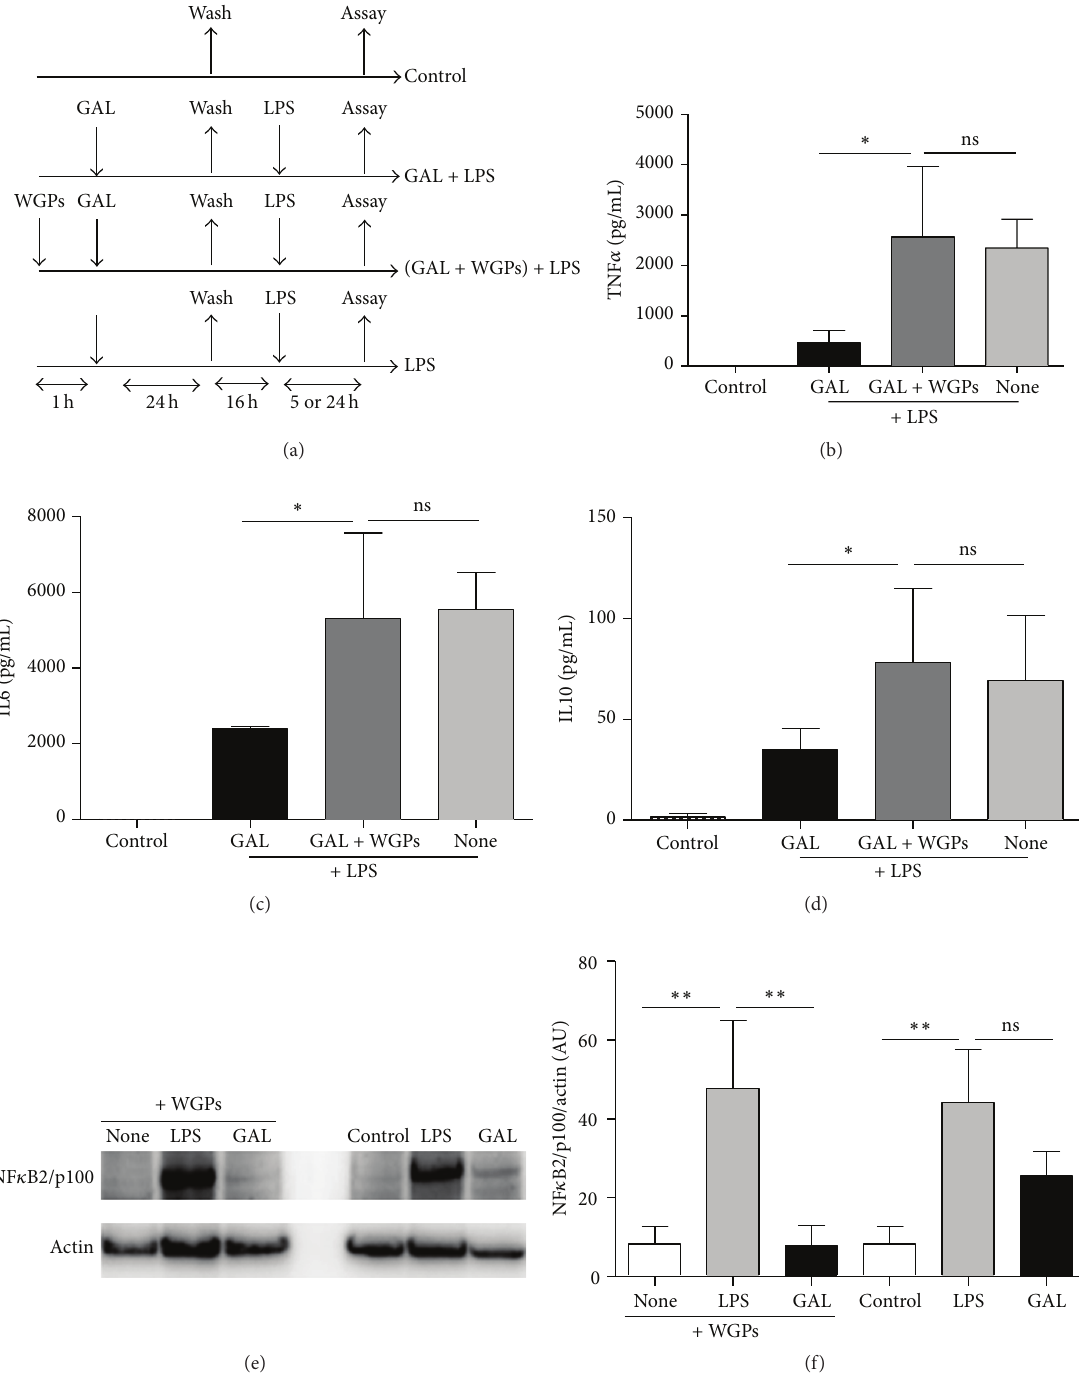
Figure 4: GAL is mediated by dectin-1 receptor. (a) Schematic representation of the inhibitor receptor of GAL model used for this study. The cultures of human macrophages were pretreated with or without WGPs (dectin-1 receptor inhibitor) 200 𝜇 g/mL for 1 hour. Next, GAL was added to the cells for 24 h, and then cells were washed three times and cultured in resting for 16h. Cells were challenged with 10ng/mL LPS for 5 h or 24 h. The controls were not pretreated. Supernatants were harvested at 5 h for TNF 𝛼 (b), 24 h for IL6 (c), and 5h for IL10 (d). Proteins levels were evaluated by CBA ( 𝑛 = 4 ); ∗ 𝑝 < 0.05 compared with LPS. Levels of NF 𝜅 B2/p100 and 𝛽 -actin were studied by Western blot analysis of the cytosolic fraction. (e) A NF 𝜅 B2/p100 standard blot is shown ( 𝑛 = 3 ). (f) Densitometry analysis: arbitrary units [AU] of NF 𝜅 B2/p100 bands are normalized with respect to 𝛽 -actin ( 𝑛 = 3 ). ∗∗ 𝑝 < 0.01 compared with